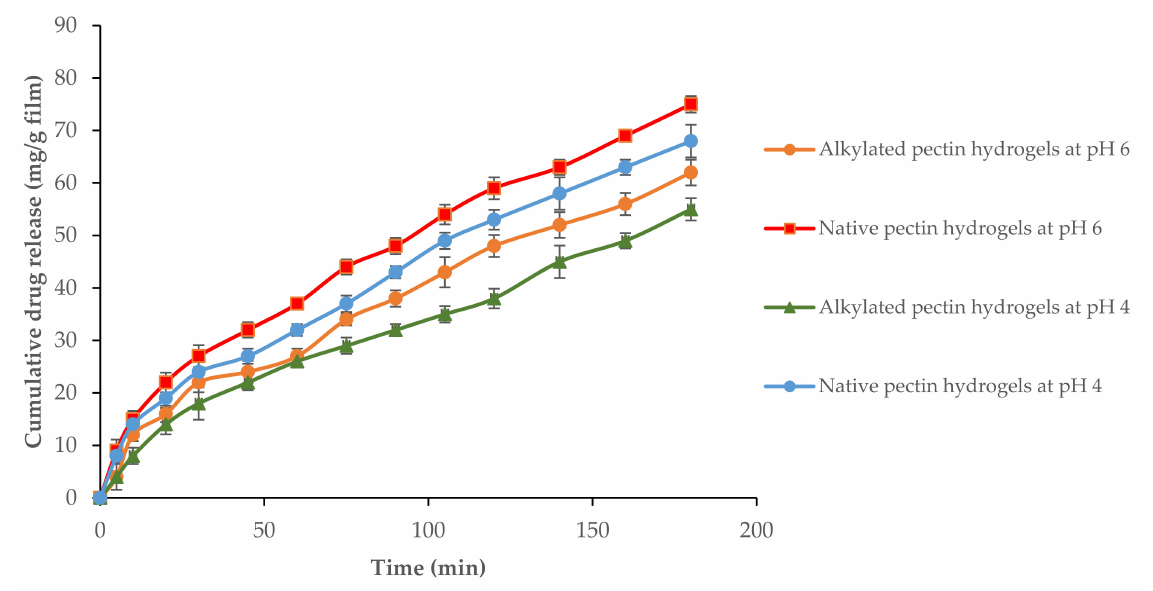
Figure 7. Fusidic acid release behavior from pectin-based hydrogels in either pH 4 or 6 buffer ( n = 3; ± SD).